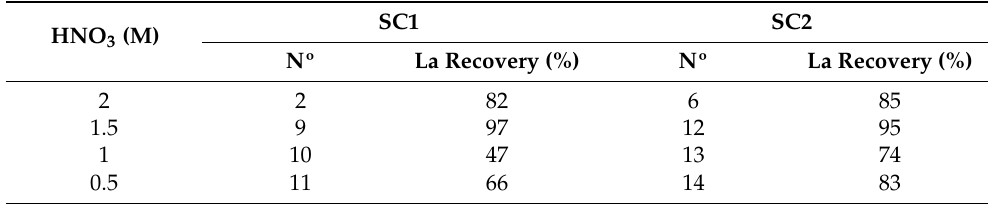
Table 3. Experimental conditions and lanthanum recovery of the different tests carried out from both starting